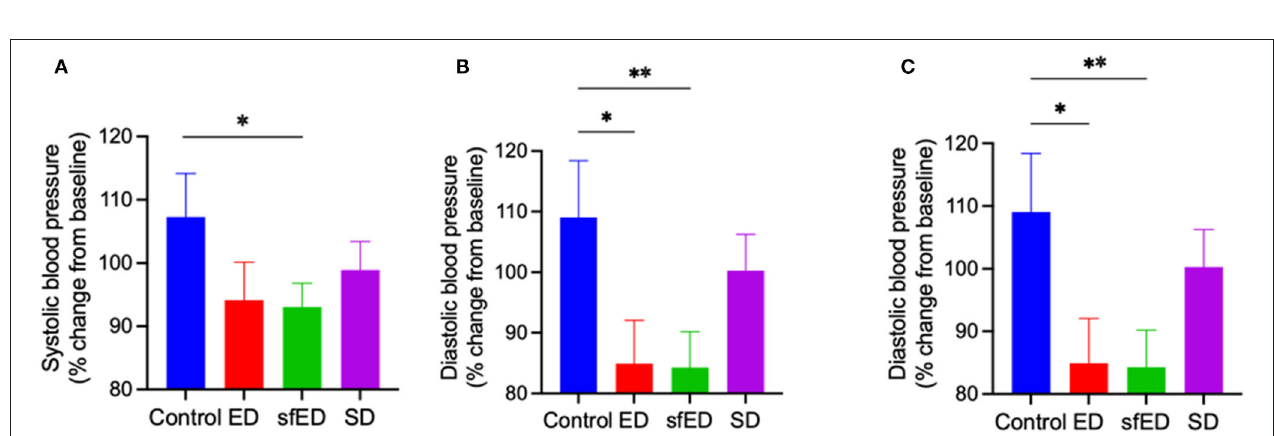
FIGURE 2 | Neuroinflammatory measures. Twenty µ m sections of brain tissue for each treatment group were stained for Iba-1 (red) and measured under a confocal fluorescent microscope. A representative image of each group is shown for both stains at low power magnification (20x) (scale bar = 20 µ m). All measures are of voxel intensity and therefore render the data to show relative levels rather than absolute concentrations. Statistical analysis was performed using one way ANOVA with Fisher’s LSD post-hoc analysis ( n = 10; *** p < 0.0005; **** p < 0.0001).